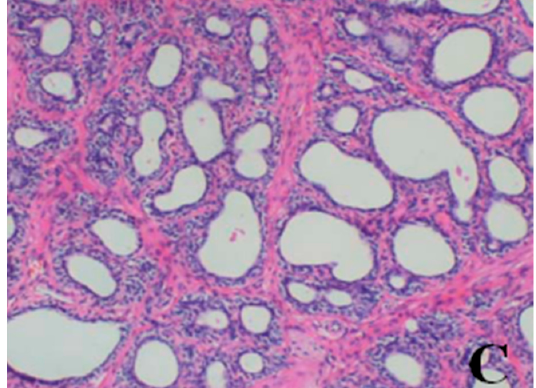
Figure 7. Hematoxylin and eosin-stained histologic sections of dogs’ prostates ( A – C ) (original magnification × 100). ( A ) Histopathological photomicrograph of the prostate from ♂ 29 belonging to the control group at d28: normal; ( B ) Prostate from 5 belonging to the 80-mg/kg dose group at d28; ♂ ♂